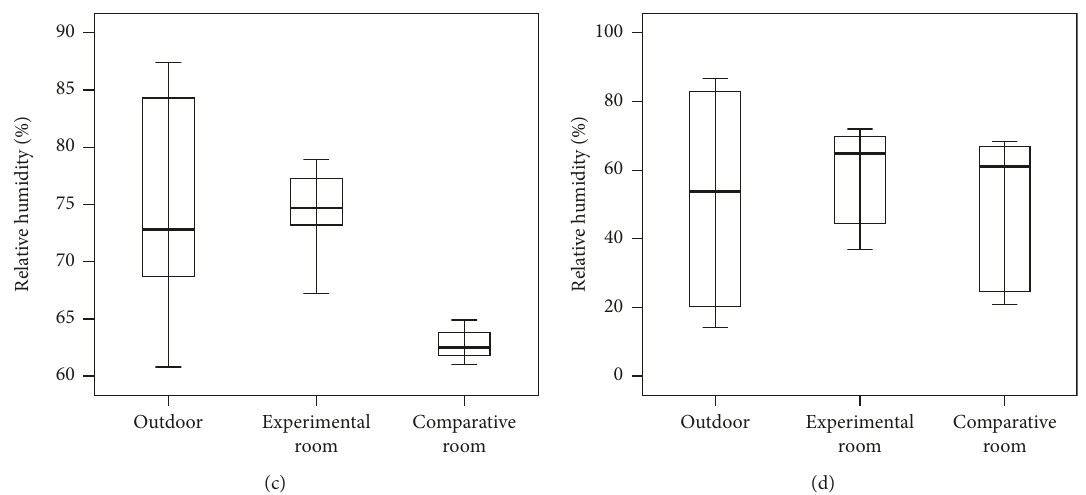
Figure 12: Outdoor and indoor temperatures and humidity variations: (a, c) Test 1; (b, d) Test